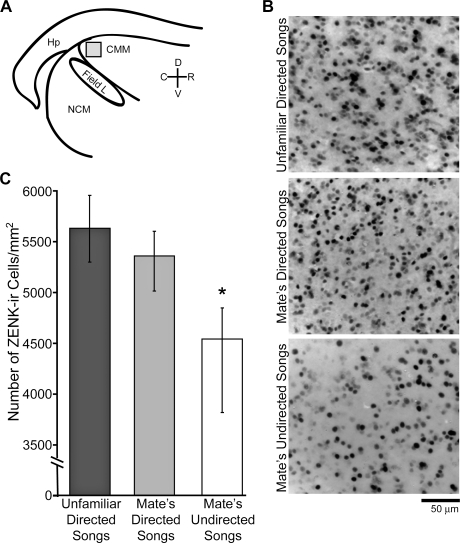
The Number of ZENK-Expressing Cells in the CMM Is Preferentially Increased by Directed Stimuli(A) Diagram of the region sampled within CMM. HP, hippocampus.(B) Representative images of ZENK staining in CMM in each of the stimulus groups.(C) Mean number of cells per area in the CMM. Females that heard their mate's undirected songs had significantly fewer ZENK-expressing cells than females that heard their mate's directed songs or unfamiliar directed songs (*p < 0.05).